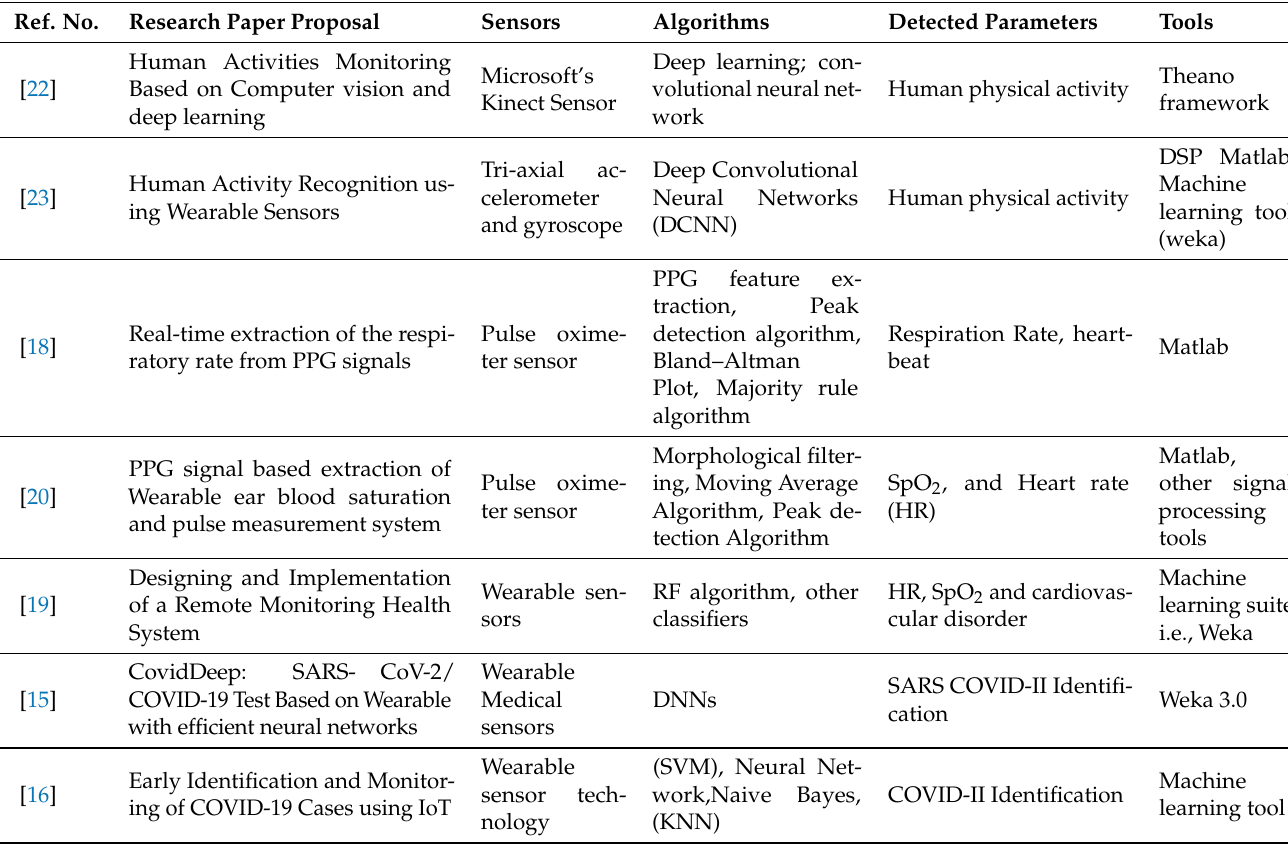
Table 1. Literature review and related works for remote monitoring and classification of SARS-COVID patients using machine learning algorithms. Ref.